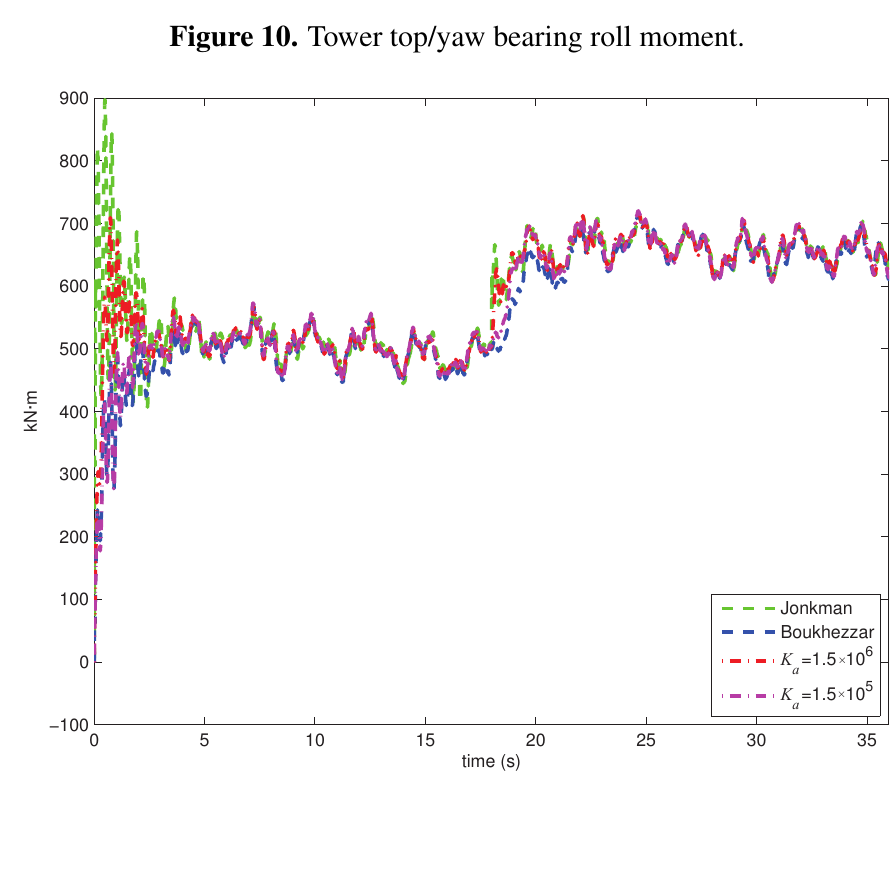
Figure 10. Tower top/yaw bearing roll